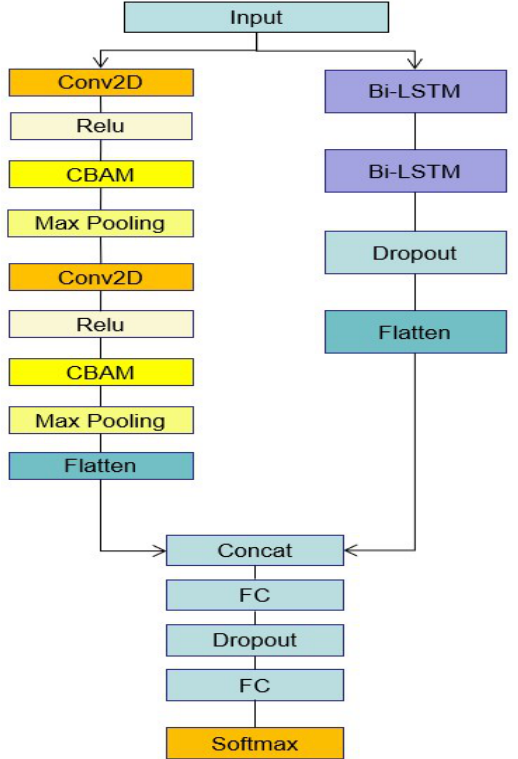
Figure 6. Schematic diagram of the CBAM-IAM-CNN-BiLSTM model.